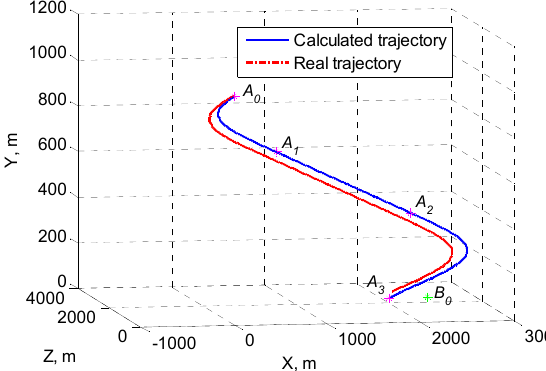
Figure 4. Space motion trajectory of the UAV.